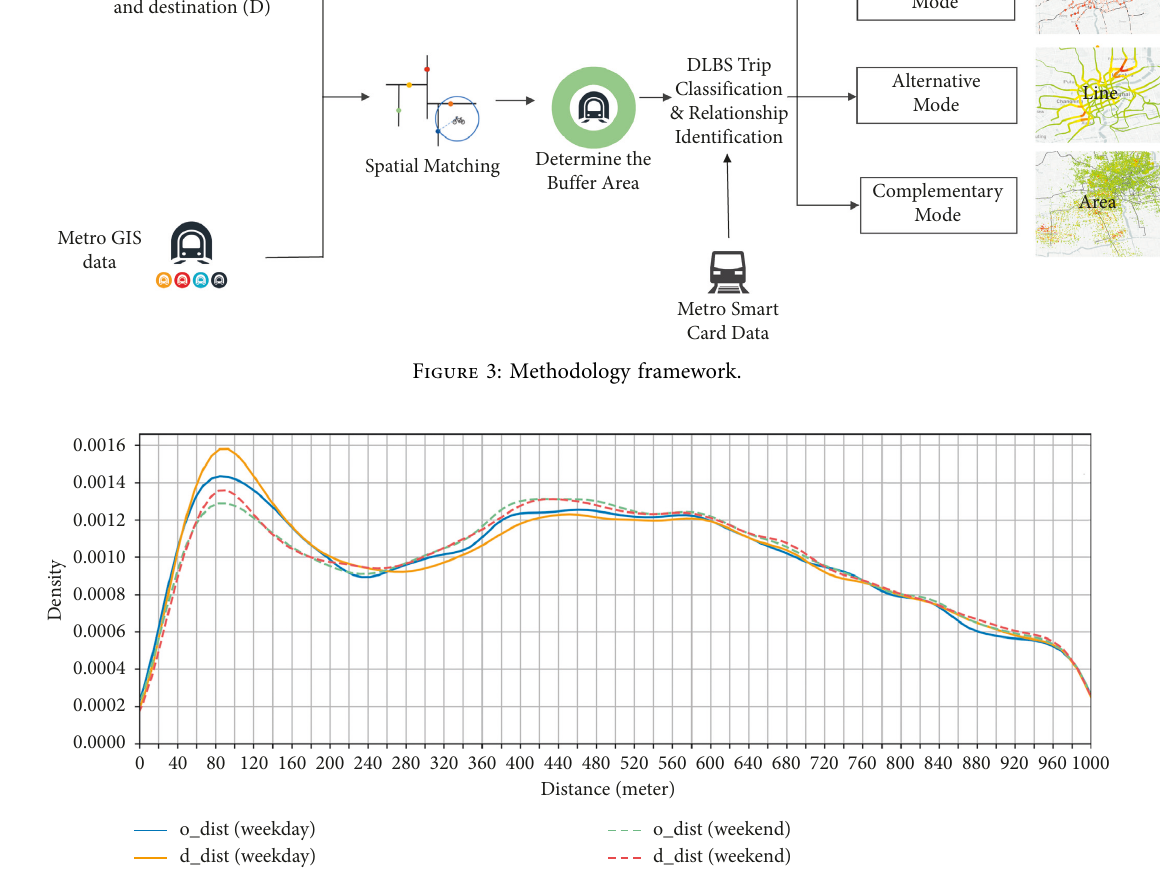
Figure 4: The estimated probability density function of the distance between the origin or destination of DLBS trips and metro stations. Table 1: Spatial relationship between DLBS trips OD and buffer zone.